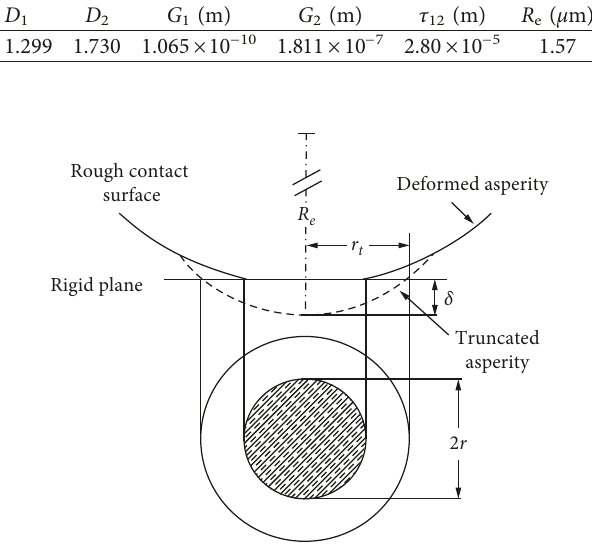
Figure 6: Schematic of a microcontact established between an asperity of composite rough surface and opposing rigid plane.